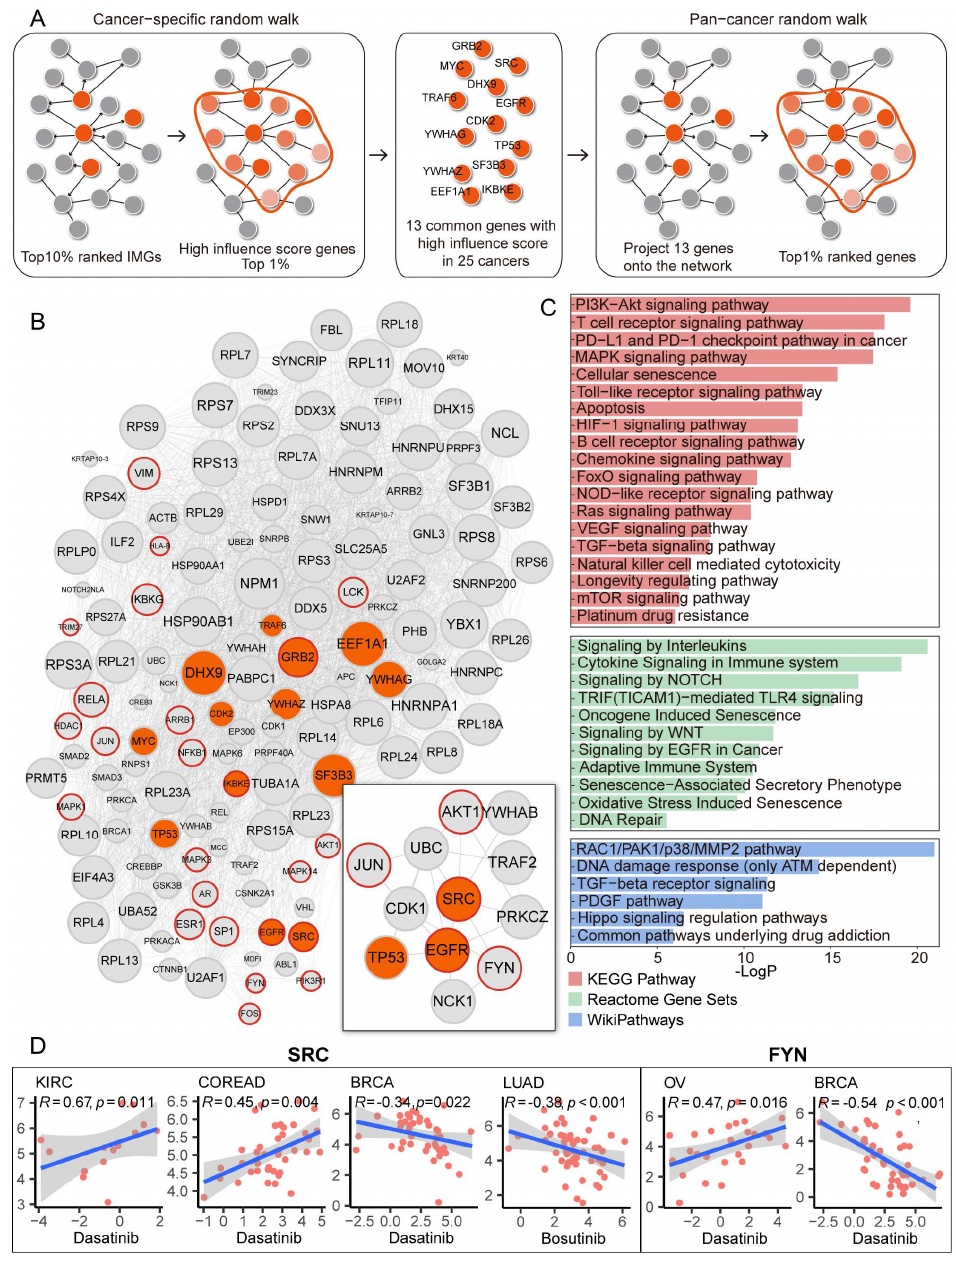
Figure 7. IRP scores were associated with patient response to immunotherapy. ( A ) Overview of identifying genes proximal to immune-related genes in pan-cancer in a PPI network. Seed genes are displayed in orange and projected onto a PPI network, followed by network propagation. ( B ) Protein–protein interaction network of top 1% genes in our prediction. The subnet in the box is the module identified by MCODE. ( C ) Bar plot showing the result of functional enrichment analysis, colors represent different data sources. ( D ) Correlation curves of the expression level of predicted drug targets and drugs in various cancer types. Dots represent the correlation between drug IC50 value and gene expression, and the blue line represents the curve fitting. The gray area represents the confidence interval. Table 1. Predicted compounds and rank of the selected genes.